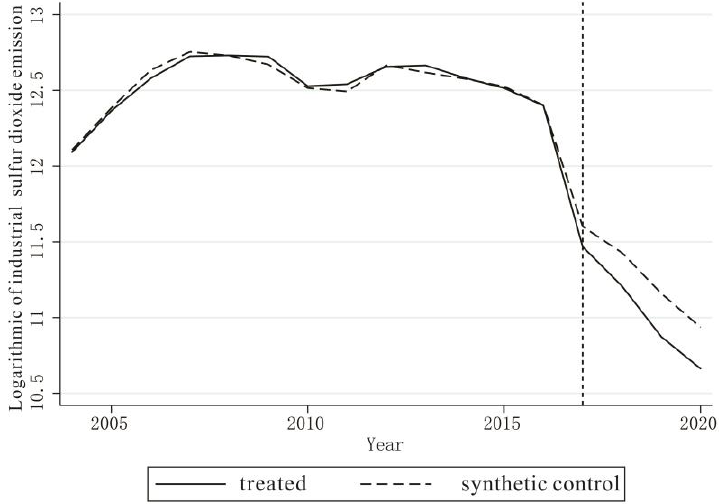
Figure 4. Industrial sulfur dioxide emission in real and synthetic black land areas.